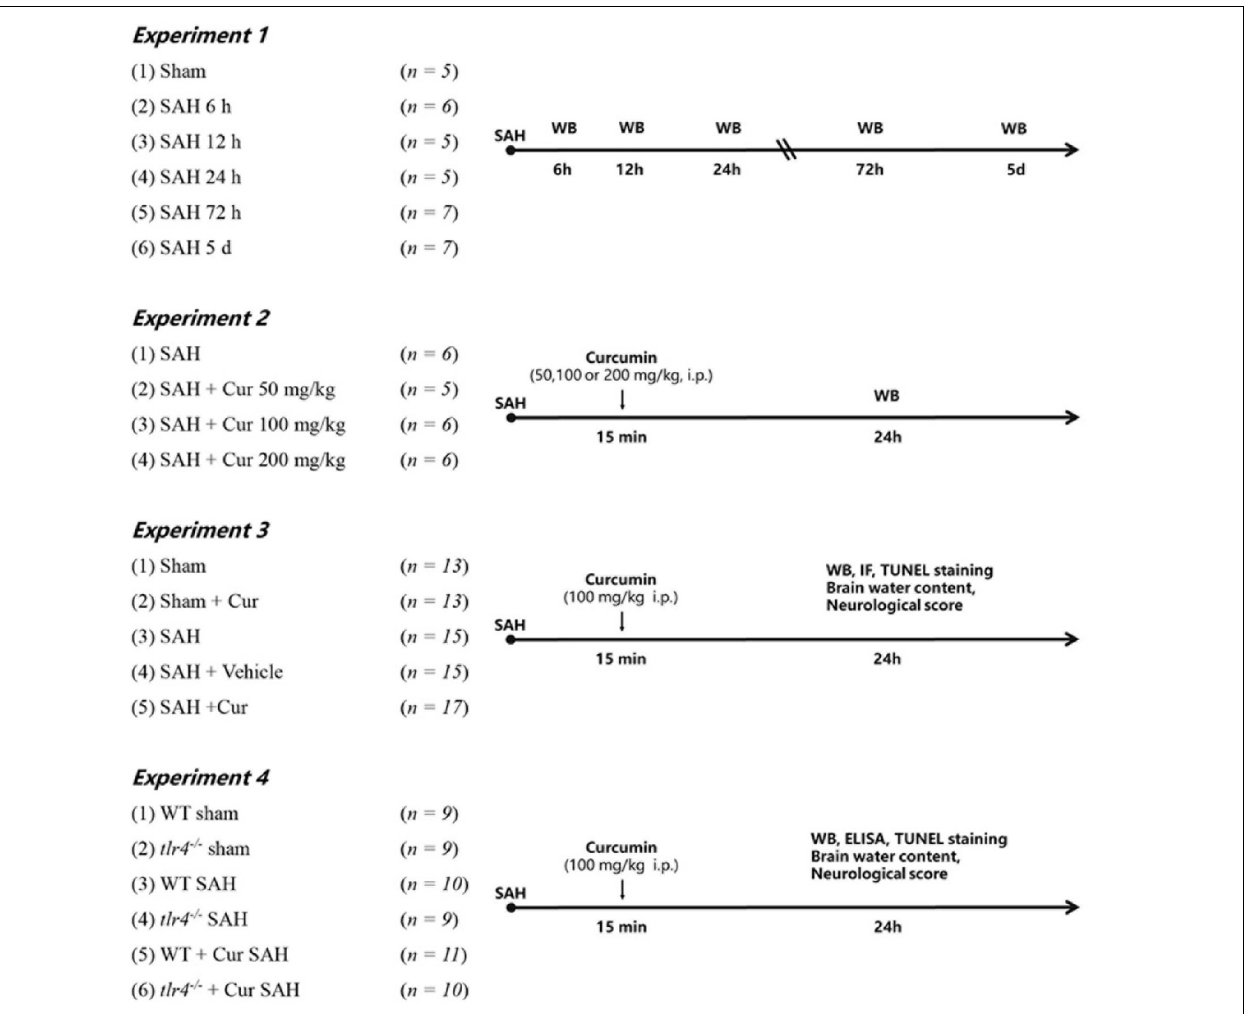
FIGURE 1 | Experimental design of this study. Cur, curcumin; WT, wild type; Vehicle, Saline containing 10% dimethyl sulfoxide (DMSO); WB, Western blotting; IF, immunofluorescence staining; ELISA, enzyme-linked immunosorbent assay.